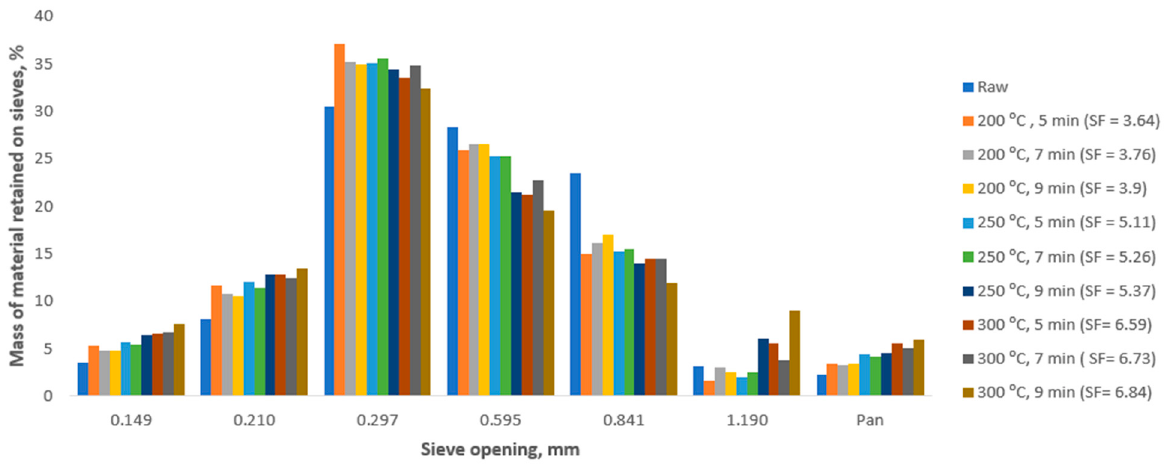
Figure 4. Particle size distribution of torrefied WSS at different severities.